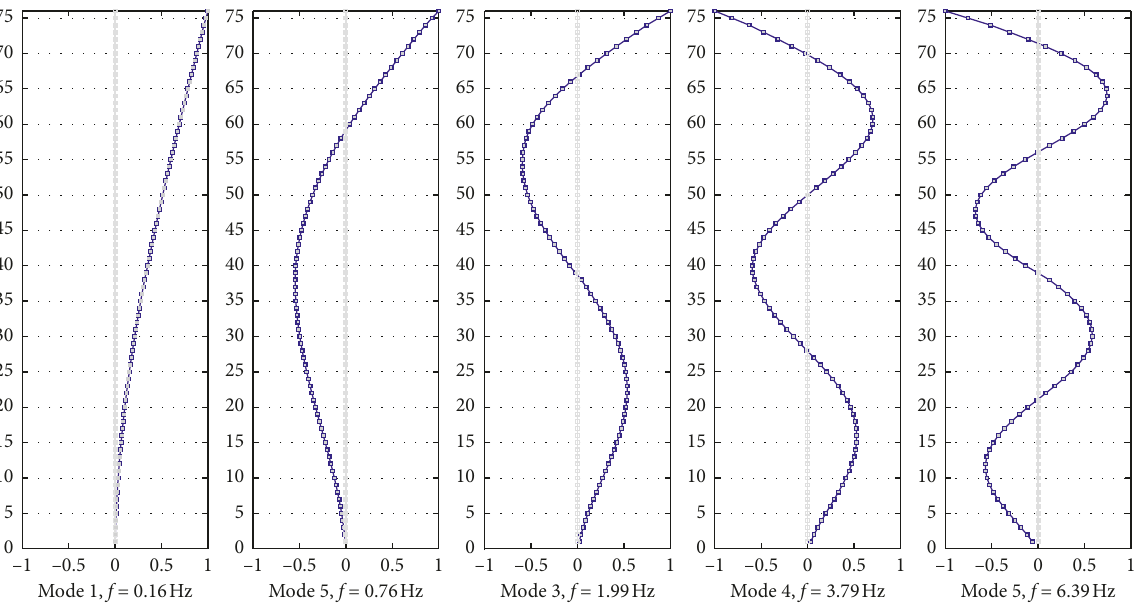
Figure 7: Five mode shapes of the 76-story building.